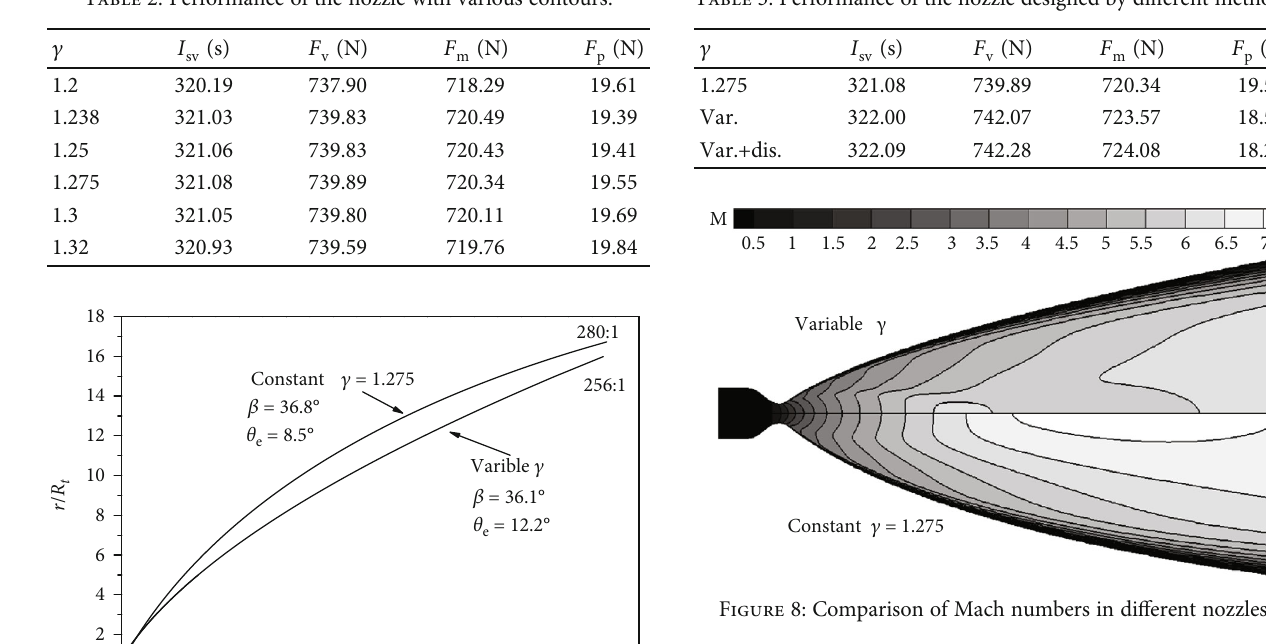
Table 3: Performance of the nozzle designed by di ff erent methods.